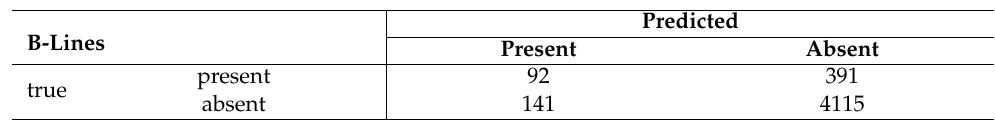
Table 5. Confusion matrix for B-lines.